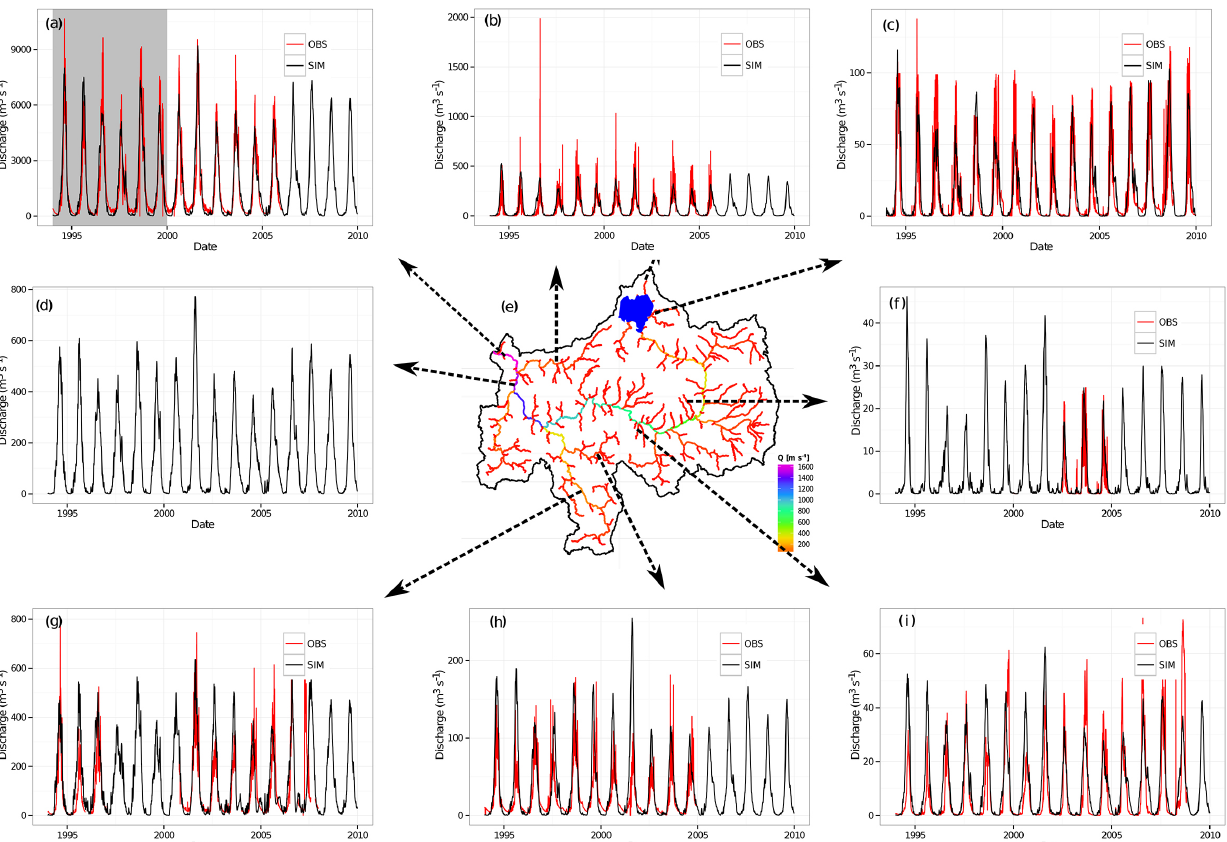
Figure 5. NewAge model simulation validation at internal subbasins. The model calibrated (shown by gray shaded period) and validated at El Diem (a) is used to estimate at each channel link and, where discharge measurements are available, they are verified: main Beles bridge (b) , Ribb River enclosed at Addis Zemen (c) , simulation of the main Blue Nile before joining Beles River (d) , Jedeb near Amanuel (f) , Dedisa River basin enclosed near Arjo (g) , Angar River basin enclosed near Nekemt (h) , and Nesh near Shambu (i) . Panel (e) shows the long-term estimated daily discharge for all river links of the basin.